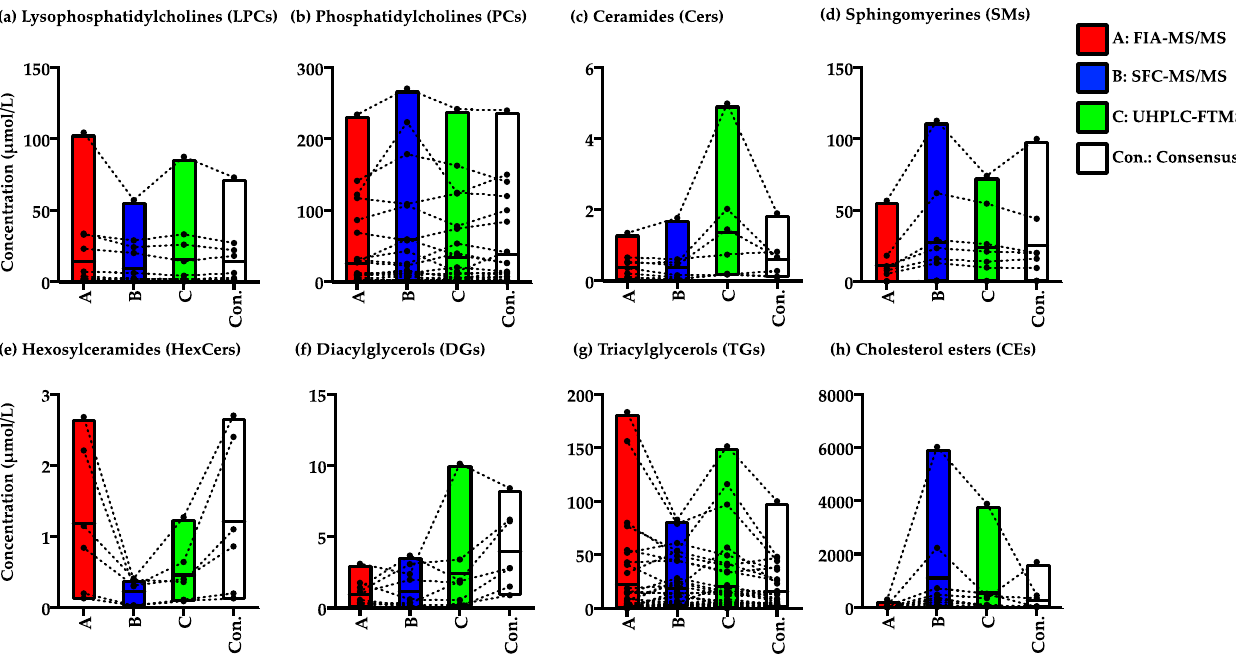
Figure 6. Summary of the individual values of lipid species quantified by the three methodologies and consensus values from the previous publication [33]. Methods A, B, and C show FIA-MS/MS, SFC-MS/MS, and UHPLC-FTMS, respectively. Box plot with the median intensity (horizonal bar) of lipid species separated for the lipid class, ( a ) lysophosphatidylcholines (LPCs); ( b ) phosphatidylcholines (PCs); ( c ) ceramides (Cers); ( d ) sphingomyelins (SMs); ( e ) hexosylceramides (HexCers); ( f ) diacylglycerols (DGs); ( g ) triacylglycerols (TGs); and ( h ) cholesterol esters (CEs); methods A, B, and C and the consensus method are colored in red, blue, green, and white, respectively. The black dotted lines are connected with the same lipid species between the three methods and consensus values. The consensus values were analyzed with a summary of quantitation MS platforms: triple quadrupole, quadrupole time-of-flight, and orbitrap (FTMS).